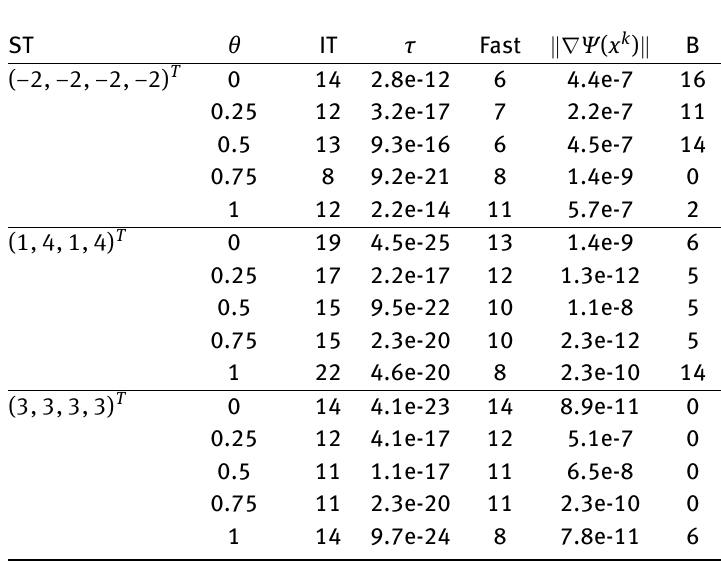
Table 1: Numerical behavior for Example